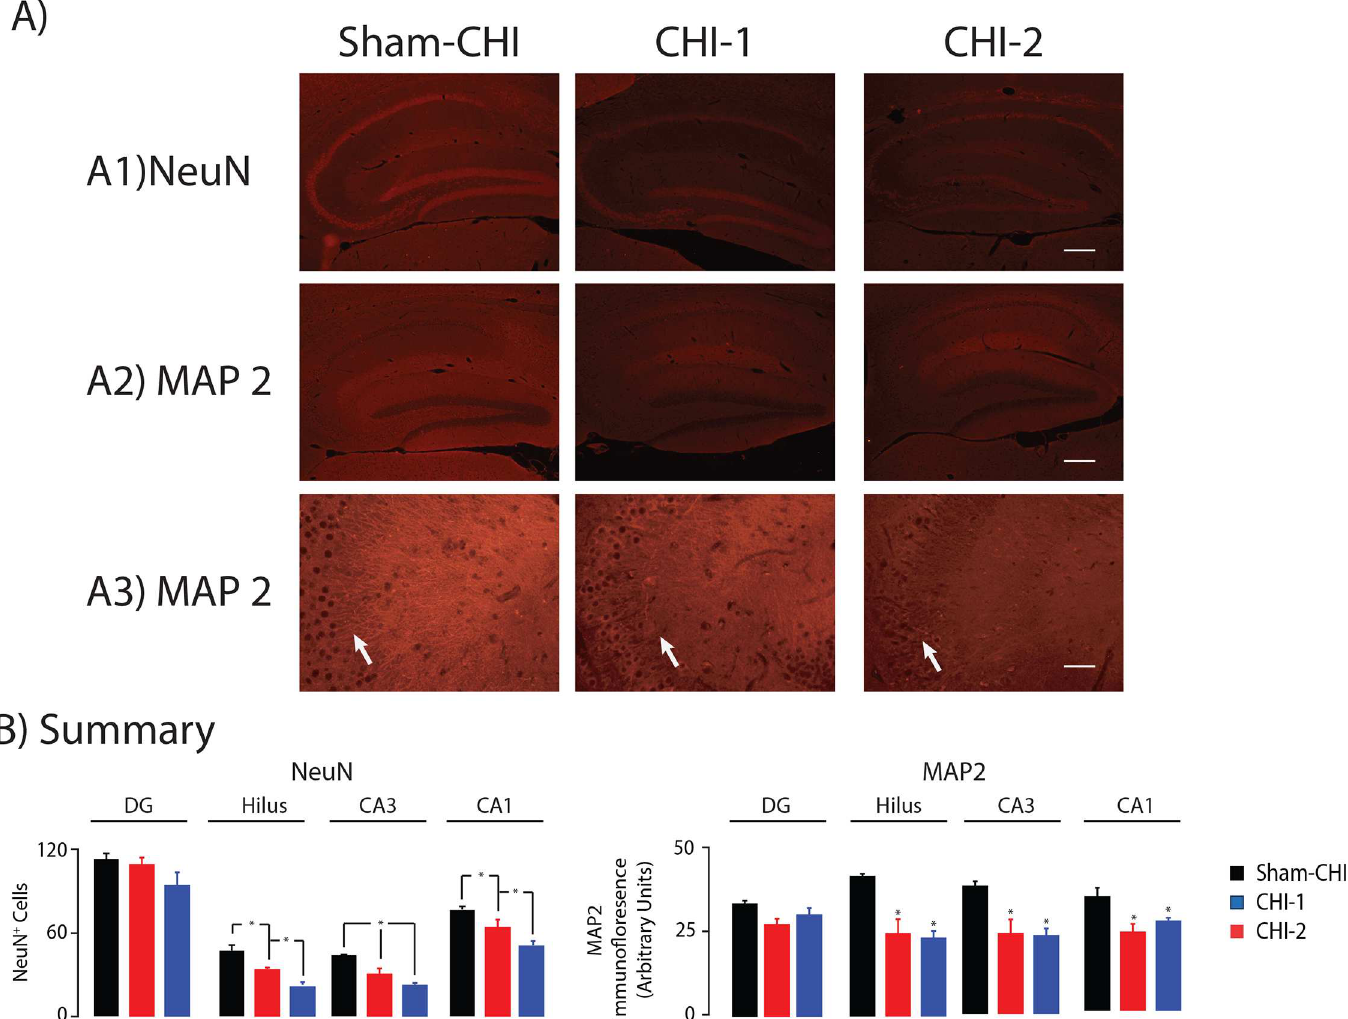
Fig 6. Grey matter injury in the hippocampi of CHI-1 and CHI-2 mice. Panel A, Representative photomicrographs of sagittal sections of hippocampus one month after injury stained with antibodies against NeuN (Panel A1) or MAP2 (Panels A2, A3). Panel A3 provides a higher magnification of the CA3 region of the images in Panel A2. Dendritesare fewer and more disorganized in the CHI-1 and CHI-2 groups (arrows). Panel B, Summary of changes in number of NeuN+ cells (left) in the CA3 and CA1 pyramidal cell layers, the granulecell layer of the dentate gyrus or the hilus. The number of NeuN+ cells in the CHI-2 group was significantly lower than the CHI-1 group in the hilus and the CA1 pyramidal cell layer (post hoc, p > 0.05). The CHI-1 and CHI-2 groups had a similar number of NeuN+ cells in the CA3 pyramidalcell layer of CA3; this number was significantly lower than in the sham-CHI group (post hoc p < 0.005). The CHI- 1 and CHI-2 groups had similar loss of MAP2 immunoreactivity in the hilus and the pyramidalcell layers of CA1 and CA3. The amount of MAP2 immunoreactivity was significantly lower than in the sham-CHI group (post hoc p < 0.05). Scale bar, 200 μ m; panels A and B; 100 μ m, panel